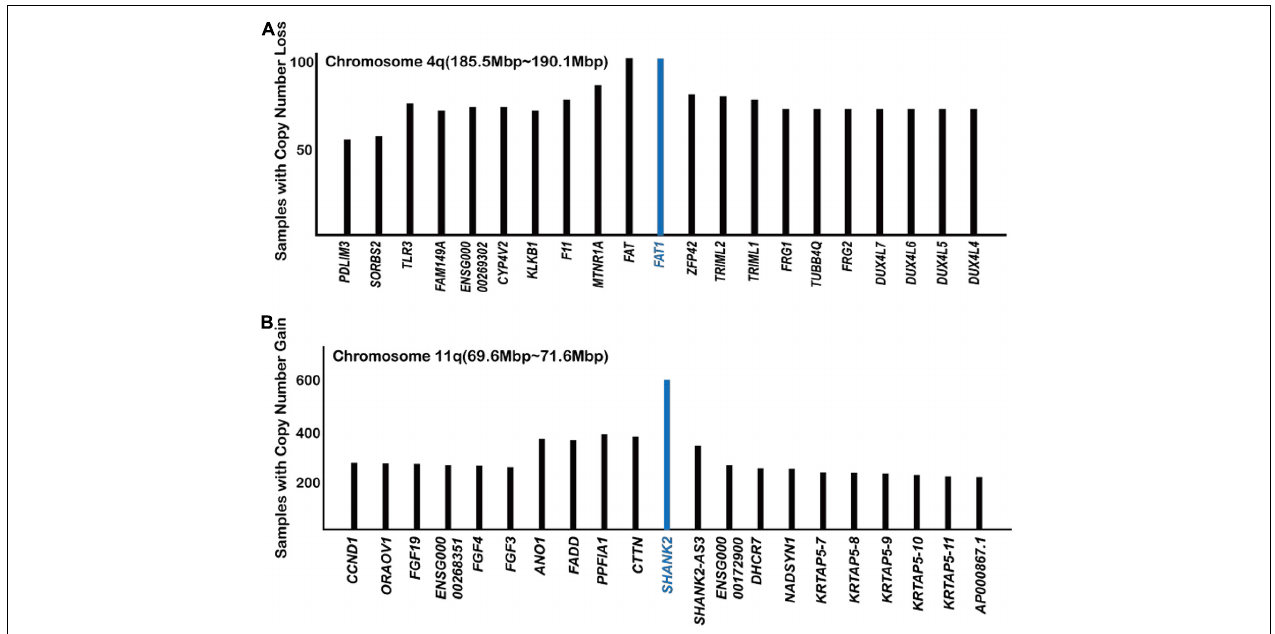
FIGURE 2 | Analysis of COSMIC gene copy number data with regard to FAT1 (A) and SHANK2 (B)